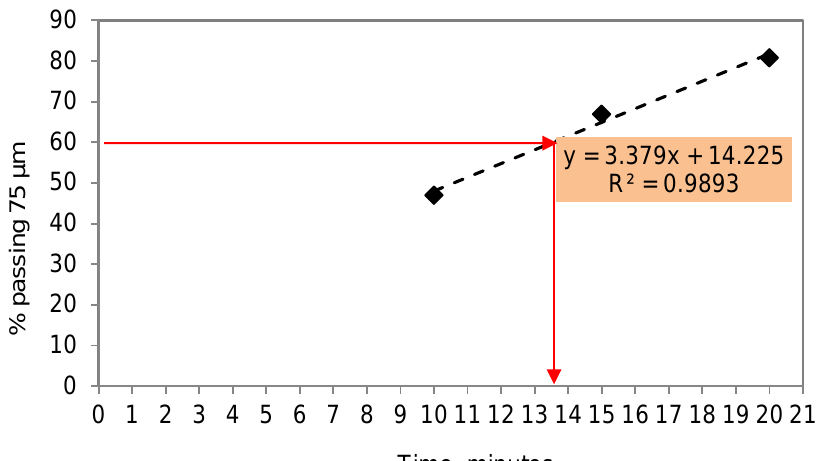
Figure 1. Milling curve for the selected Merensky ore.